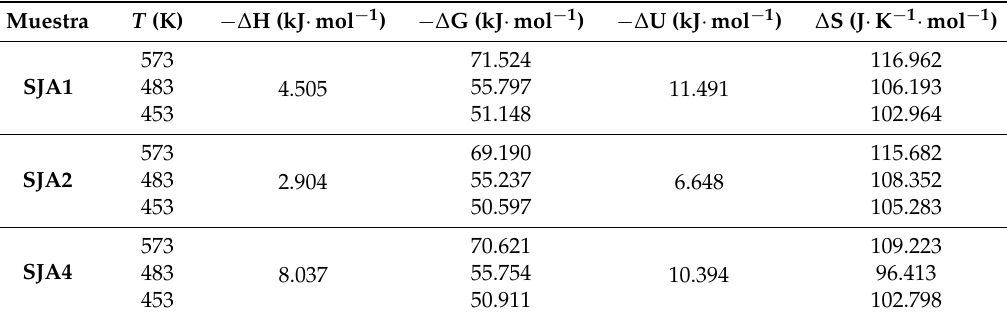
Table 4. Thermodynamic data for adsorption of CO 2 on SJA1, SJA2 and